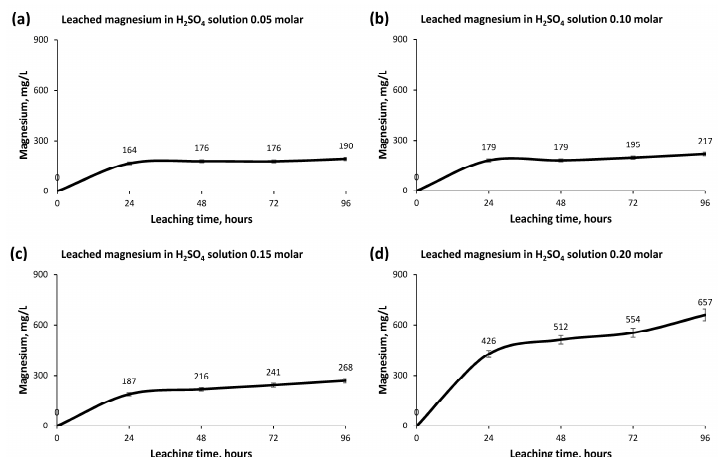
Figure 6. Analysis of the concentration of Magnesium in the leaching process at atmospheric pressure, ambient temperature and in different solutions of Sulphuric Acid: ( a ) 0.05 molar H 2 SO 4 solution, ( b ) 0.10 molar H 2 SO 4 solution, ( c ) 0.15 molar H 2 SO 4 solution and ( d ) 0.20 molar H 2 SO 4 solution.